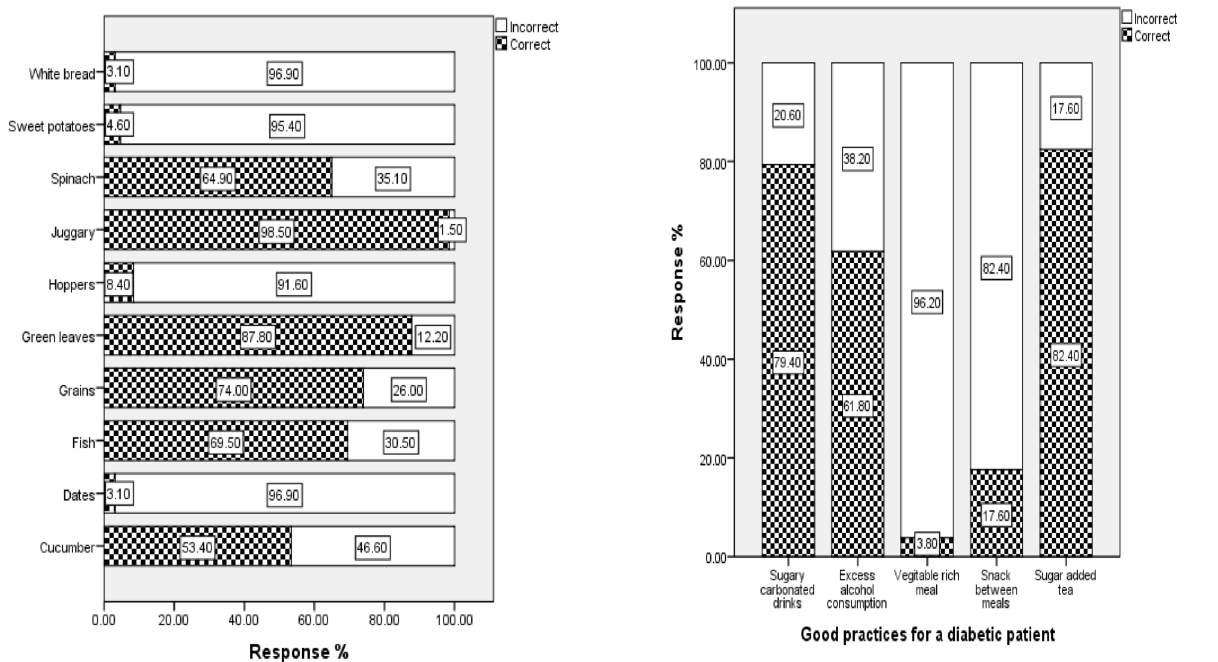
Figure 2A: Diabetic diet